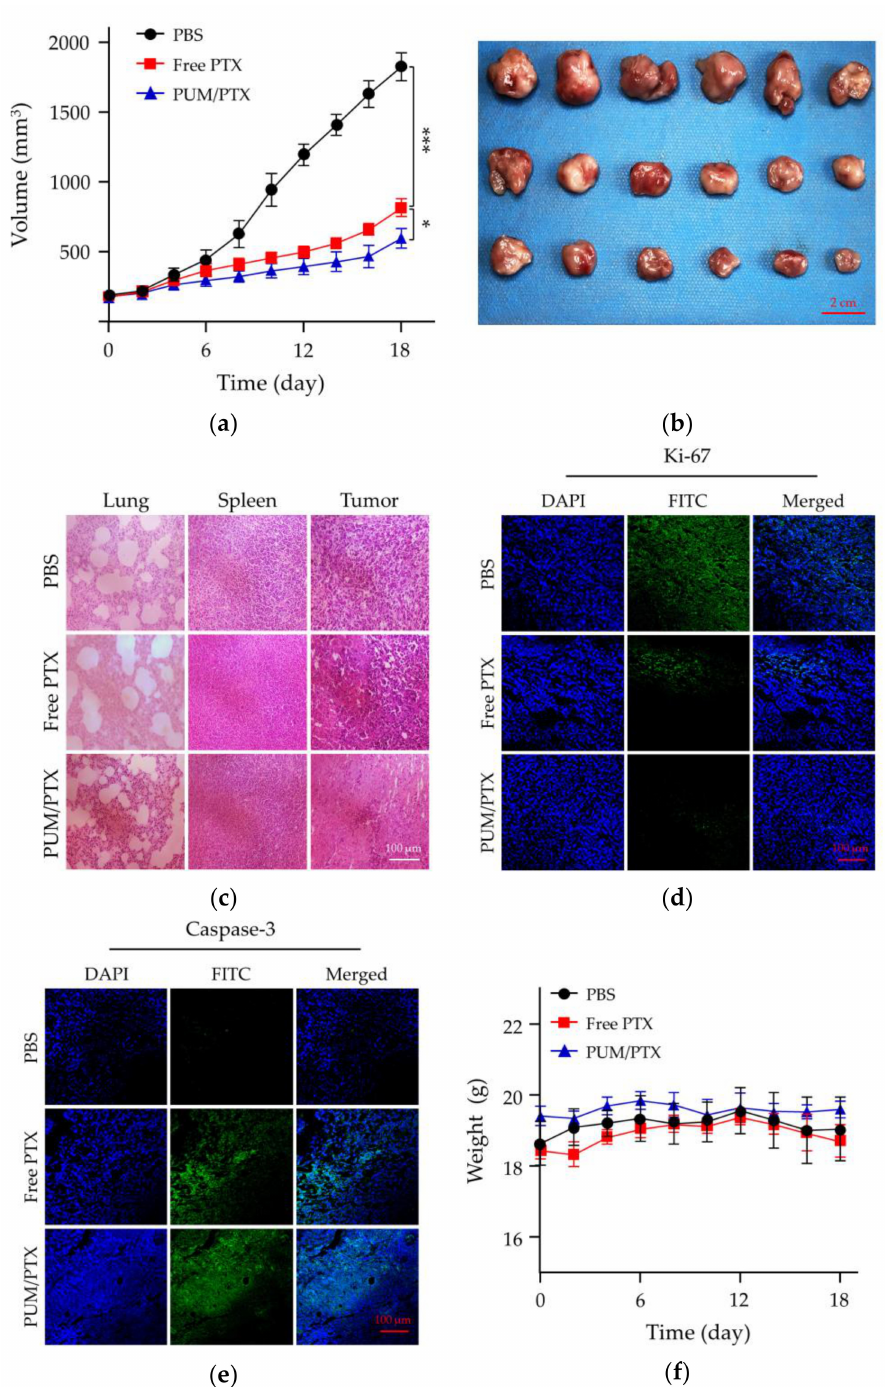
Figure 5. In vivo antitumor e ffi cacy, safety assessment, and immunofluorescence experiments. ( a ) Tumor volumes and ( b ) photograph of the isolated tumors. Data were presented as a mean ± SD ( n = 6; * p < 0.05, ** p < 0.01, *** p < 0.001); ( c ) Hematoxylin and eosin (H&E) staining of normal organs (the lungs and spleens) and tumor tissues; ( d ) Ki-67 staining of tumor tissues; ( e ) Caspase-3 staining of tumor tissues; ( f ) Changes of body weight in each group ( n =